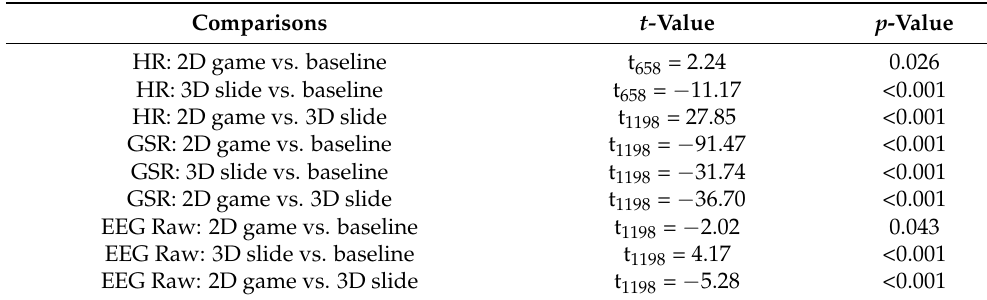
2D game, and 3D slide conditions.